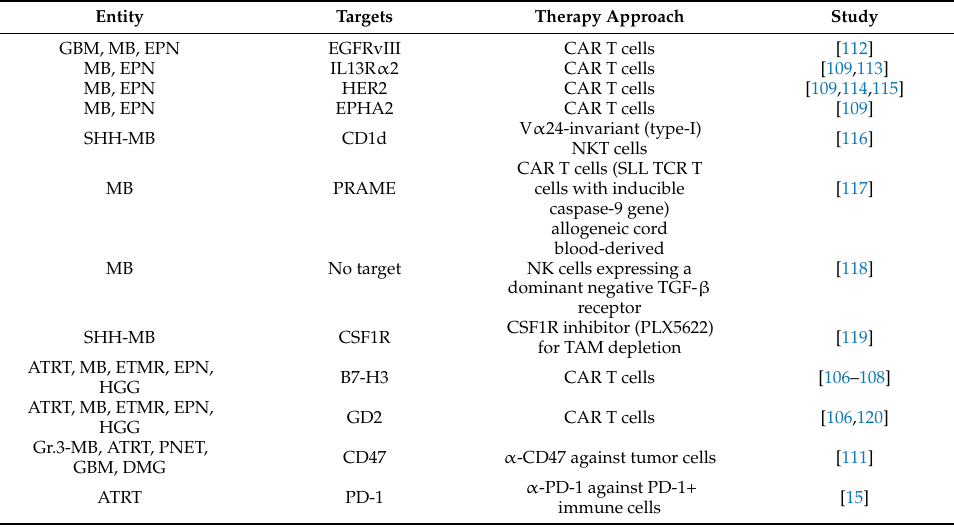
Table 3. Targets for immunotherapy in pediatric brain